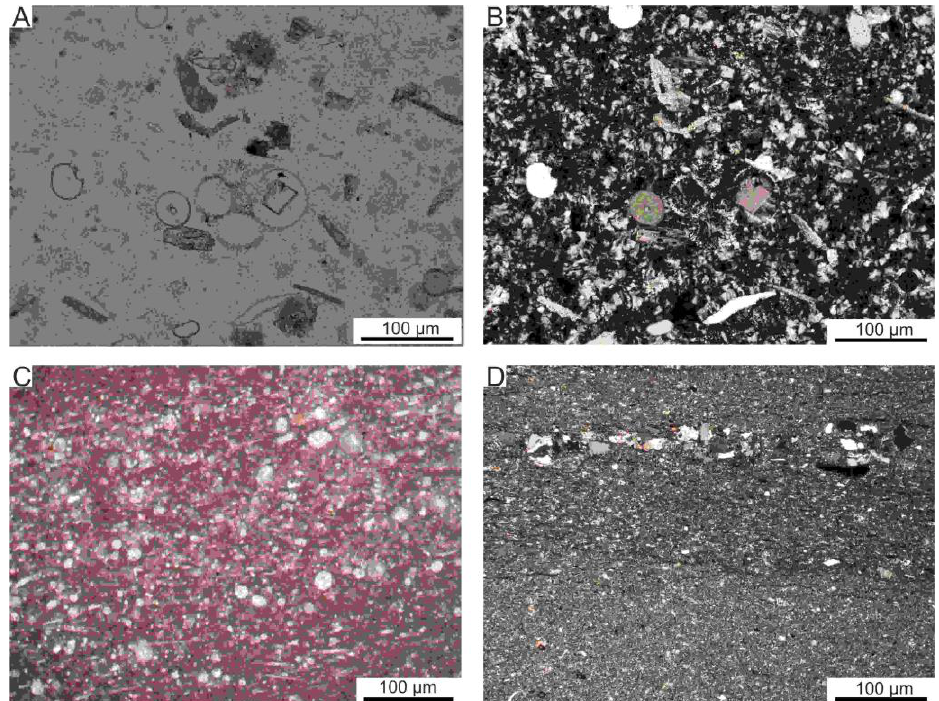
Figure 7. Examples of microfacies dominated by clay- and silt-sized particles in the Mikuszowice Chert Beds. ( A , B ) Foraminiferal biomicrite (the same view in crossed pollars ( B )), partly silicified (subsection B), sample J3205. ( C ) Radiolarian biomicrite (subsection C), sample J3117. ( D ) Hemipelagic siltstone (subsection D), sample J3002. All photos oriented perpendicular to layering.